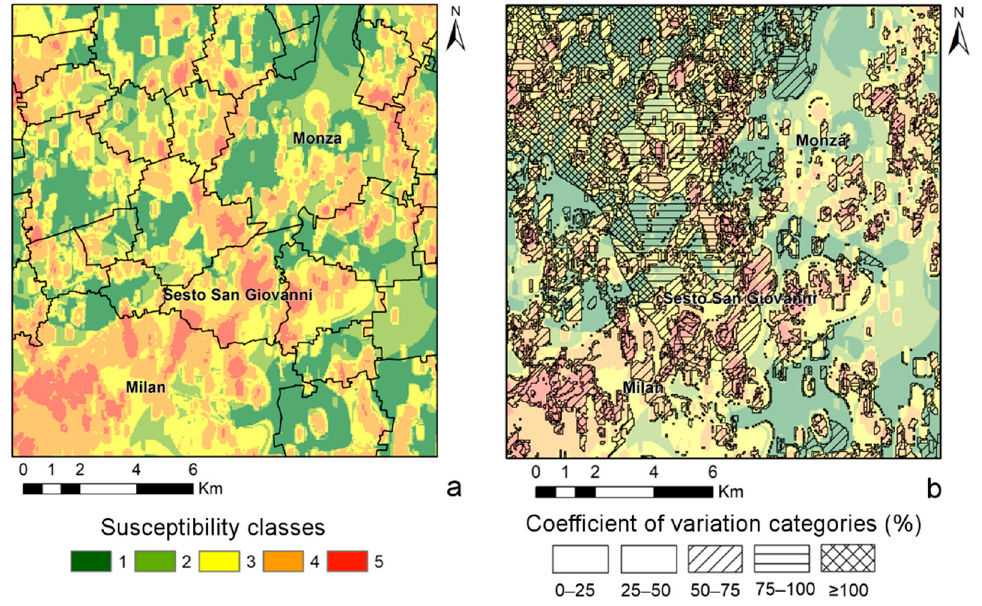
Figure 7. ( a ) Map representing the distribution of susceptibility classes within the study area; ( b ) map representing the coefficient of variation (%) overlaid on the susceptibility map (in transparency). The degree of susceptibility increases from green (class 1) to red (class 5) colors.